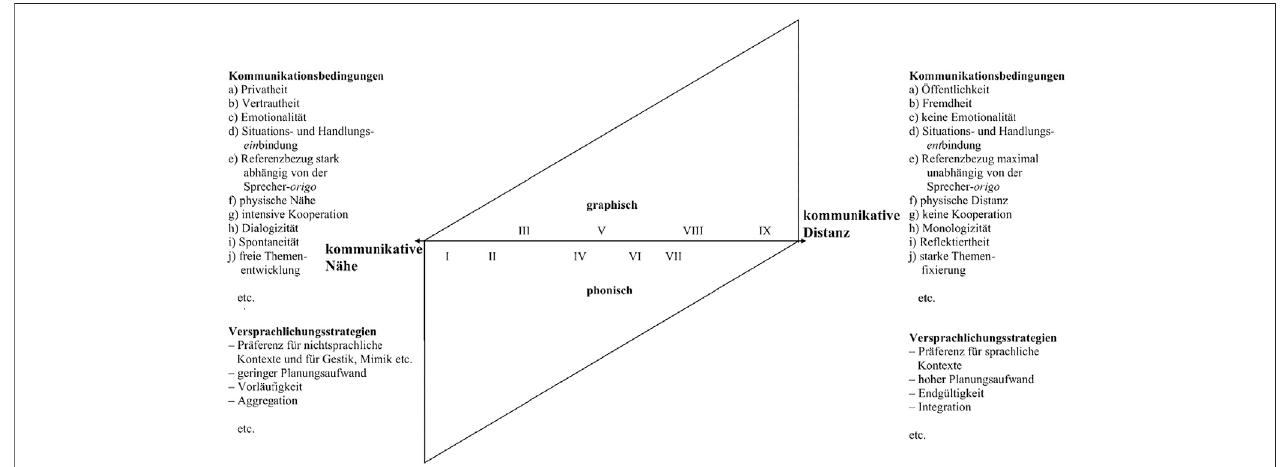
FIGURE 3 | Spoken vs Written Language according to Koch-Österreicher 1990: